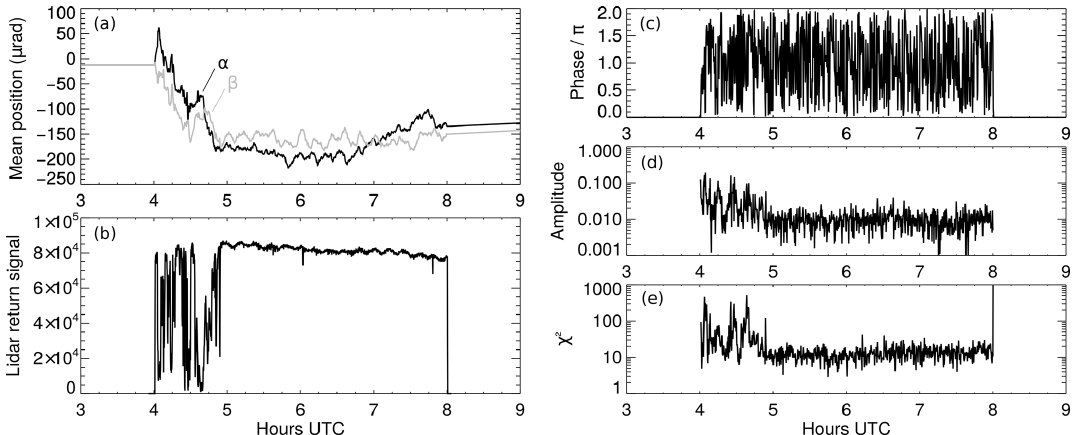
Figure 7. Performance of the conscan system during the measurement on 3 November 2019. (a) Mean scan mirror angles, (b) lidar return signal integrated between 45 and 55km altitude, (c) phase and (d) amplitude of the demodulated conscan signal, and (e) goodness of the